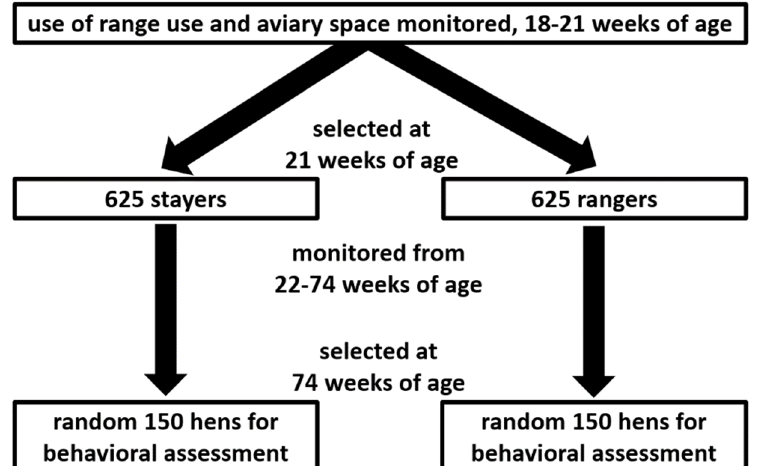
Figure 1. Flow chart representing the selection process of experimental hens subject to the behavior tests in each of the three flocks investigated on a commercial farm. While 300 hens / flock were targeted and tested for behavior analysis, 769 hens were included in the statistical analysis due to incomplete datasets. The 625 stayers and rangers present in each of the three flocks were housed in separate pens as required for a parallel experiment.